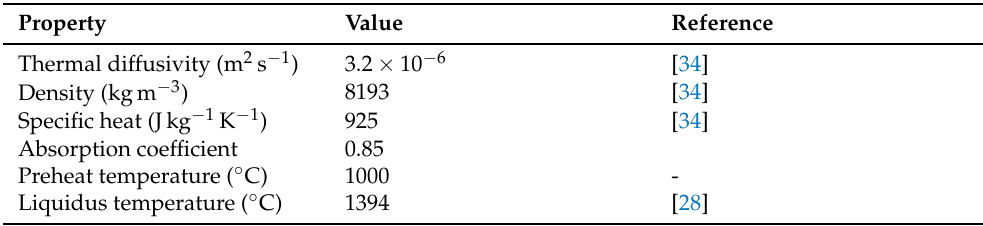
Table 4. The material properties for CMSX-4 ® used in simulation.